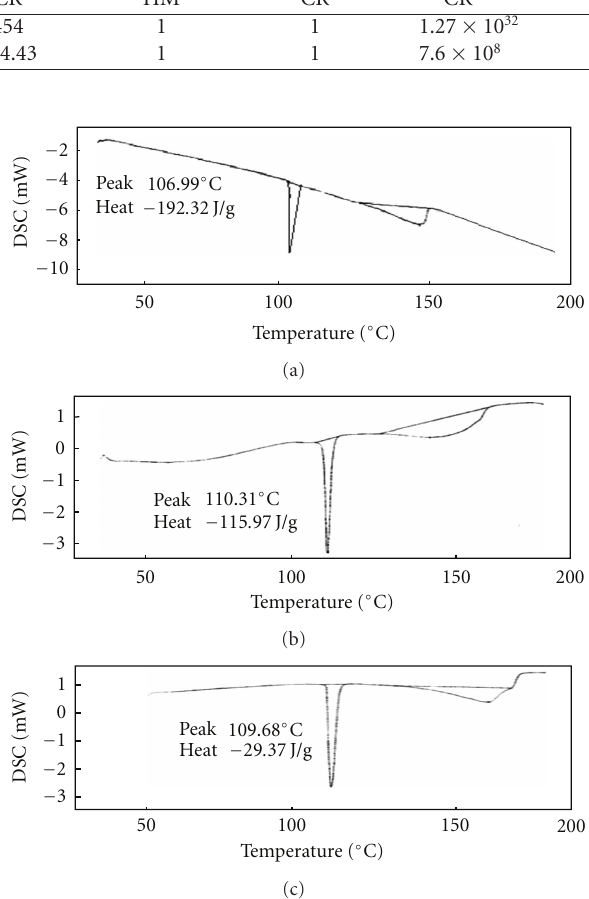
Figure 3: DSC profile of dimethyl sulfone drug substance (a), MSM tablet (b), and Genuphil tablet